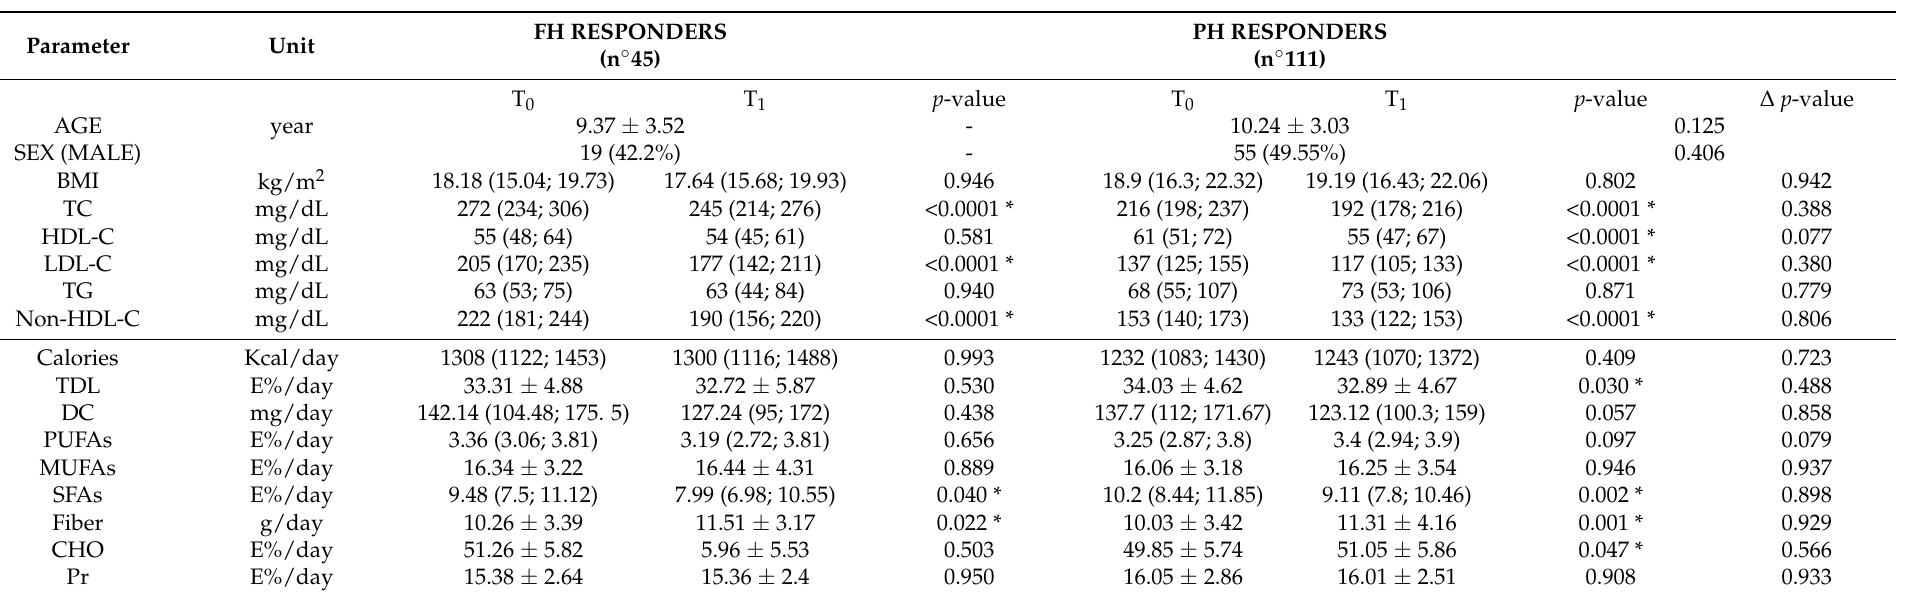
Table 3. Lipid profile and daily dietary intake at baseline (T0) and at 6 months follow-up (T1) and estimated changes (Delta) between the FH and PH in the Responder